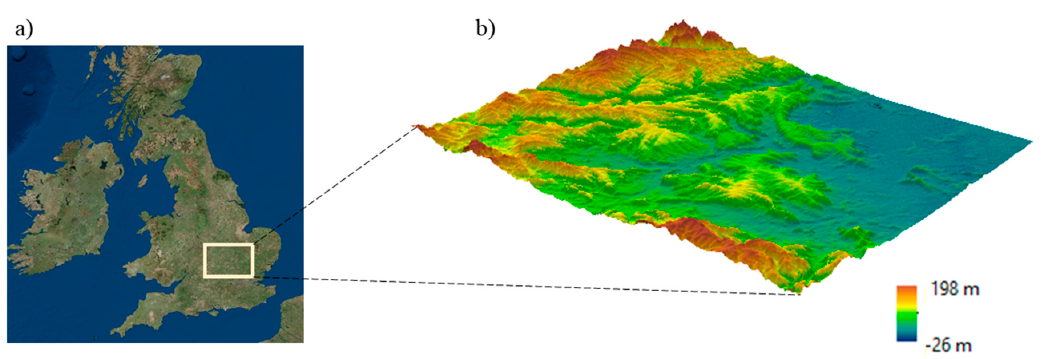
Figure 2. ( a ) Location of study area, and ( b ) 3D visualization of the SRTM 30 DEM.